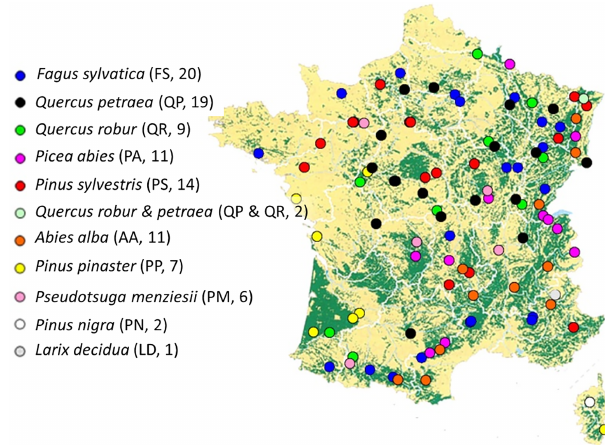
Figure 1. Geographical distribution of the sites in the RENECO- FOR network used to test Yasso07 performance (see also Jonard et al., 2017). Forested areas are represented in green. Each circle rep- resents one site; the color represents the dominant tree species on the plot. The species abbreviation and number of sites per species are indicated in parentheses. One site ( Picea abies 39b) was not used due to data